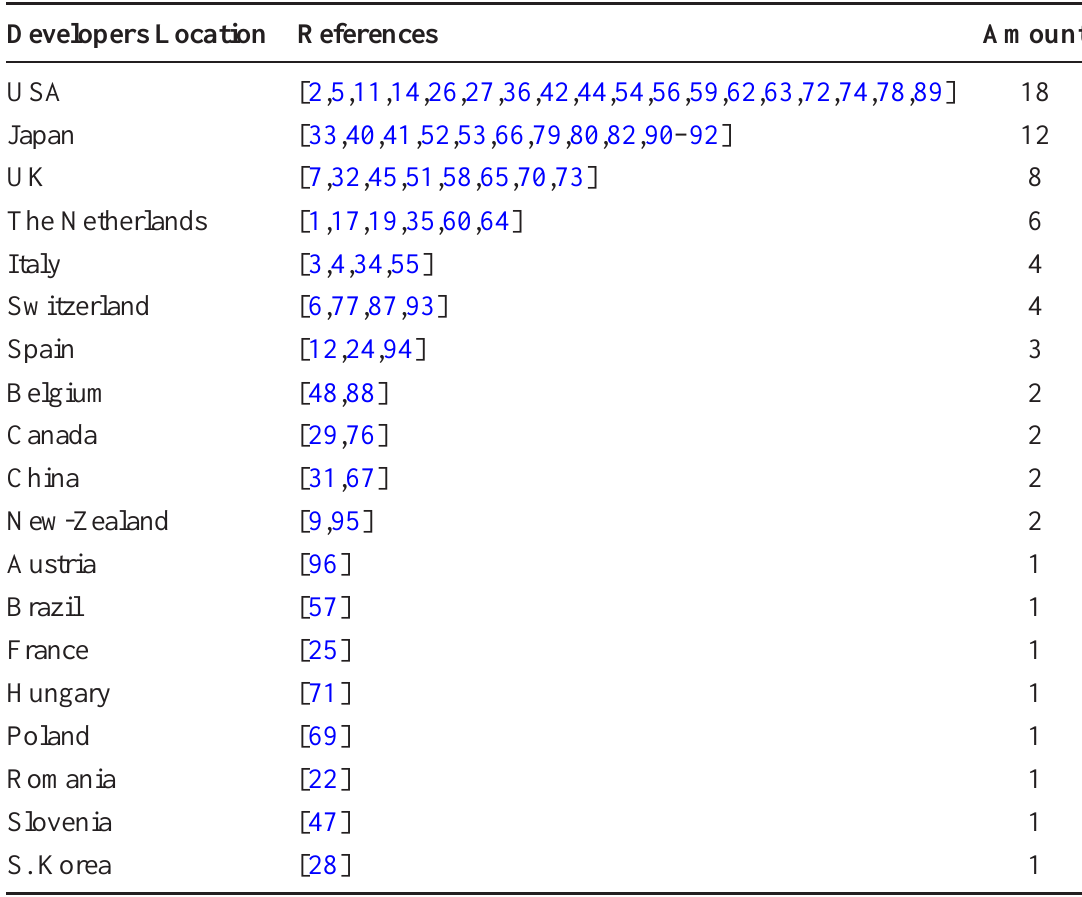
Table 4. The geographic distribution of the first authors from the used